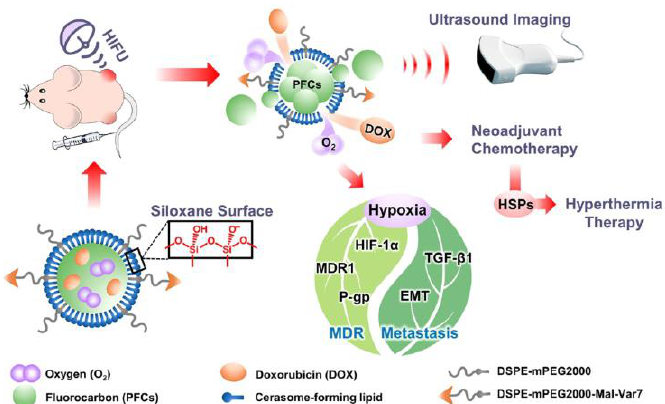
Figure 20. The schematic demonstration of a complex chemotherapeutic system. The cerasomes loaded with oxygen and DOX are delivered to tumor sites, where ultrasound irradiation helps release the cargo for dual action of treating hypoxia to prevent drug resistance and metastasis, and producing a cytotoxic effect caused by DOX for tumor mitigation. Reprinted with permission from [280]. Copyright 2020 American Chemical Society.